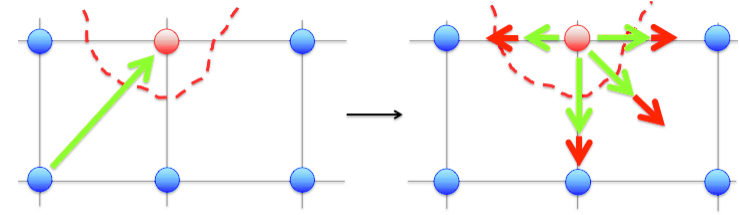
Figure 2. Sketch of the reactive boundary condition.